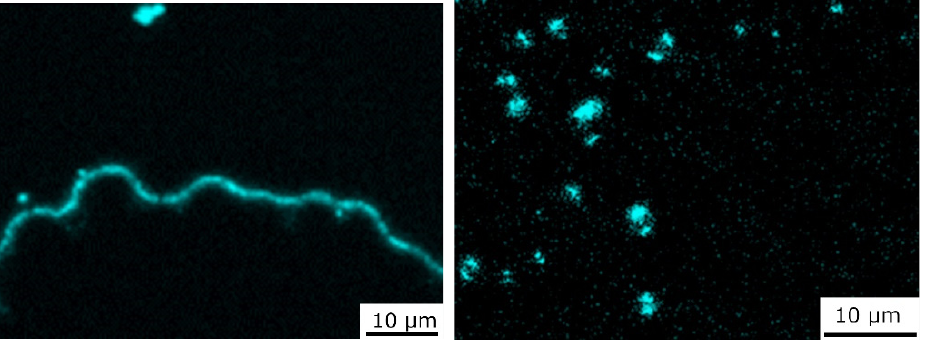
Figure 6. EDX yttrium distributions of Mg1.8Y/T300 ( left ) and Mg1.8Y/Granoc ( right ) composites.